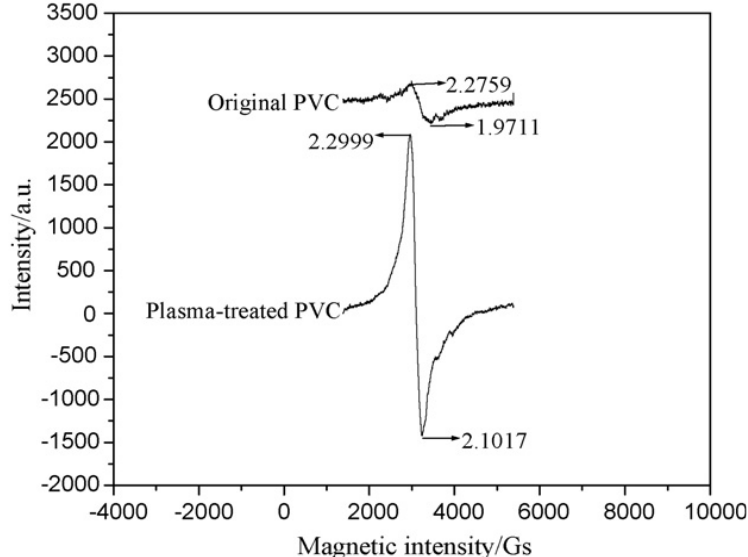
Figure 1. Electron spin resonance spectra of pristine and plasma-treated PVC surfaces (Reprinted with permission from [45]. Copyright 2008 Elsevier).